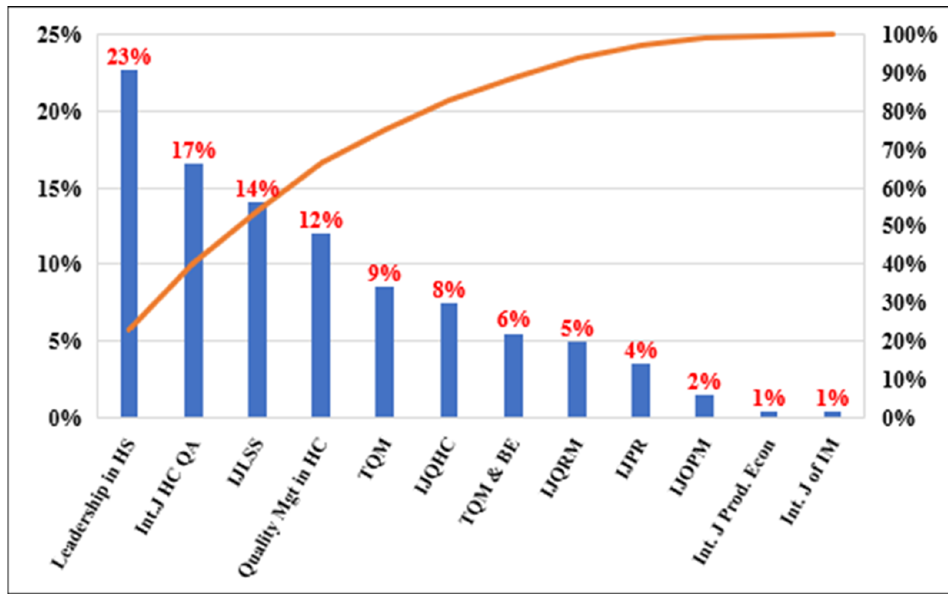
Figure 4. Journals with the majority of articles related to Lean in Healthcare. (orange bar = pareto line, blue bar = % contribution (visual) red number = % contribution (numerical)